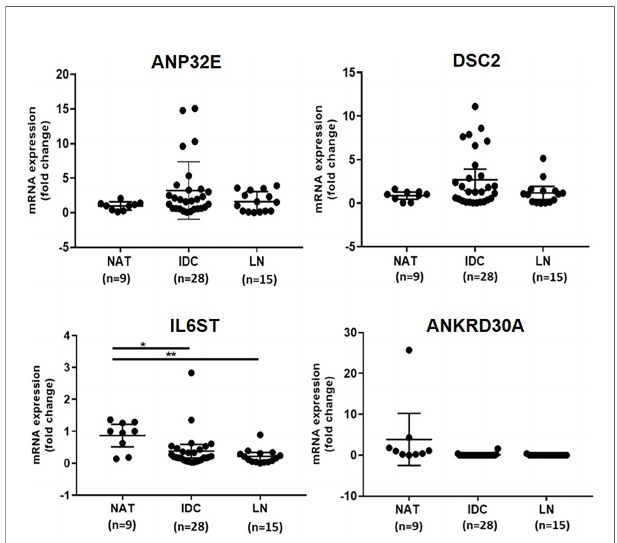
FIGURE 1 | Veri fi cation of differential expression of ANP32E, DSC2, IL6ST and ANKRD30A genes at the mRNA level in tumour compared to normal tissue in the fi rst cohort. The mRNA expression of ANP32E, DSC2, IL6ST and ANKRD30A genes obtained as copies per m l using ddPCR. Results show the fold change expression of four genes in IDCs and LNmets compared to NATs. Values are presented as the median ± interquartile range. A Kruskal- Wallis test followed by Dunn ’ s test for multiple comparisons was performed to determine the statistical signi fi cance of the expression. A p value ≤ 0.05 was considered signi fi cant. Asterisks in the fi gure represents statistical signi fi cance (*p ≤ 0.05; **p ≤ 0.01). NAT, Normal adjacent tissue; IDC, Invasive ductal carcinoma and LNmet, Lymph node